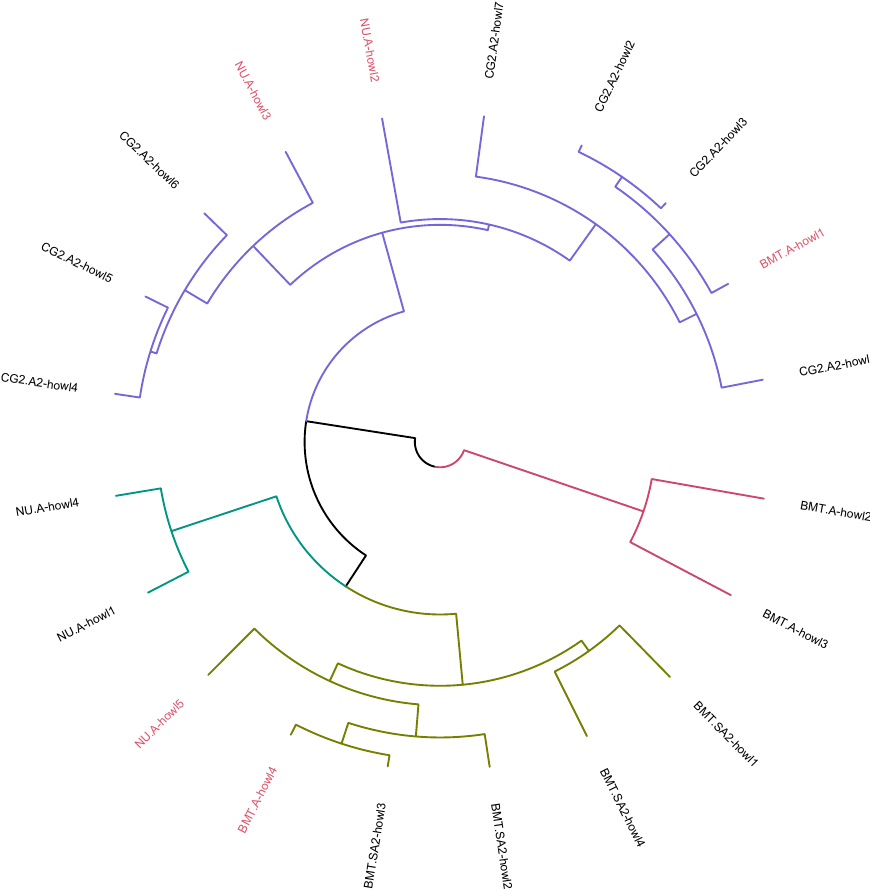
Figure 7. Hierarchical Clustering of 20 howls from four Indian wolves. None of the 20 howls was used in training the data. 15 howls were identified correctly with the accuracy of 75%, and all the four individuals were identified correctly as different clusters. The correctly identified howls are marked in black, and the five wrongly identified howls are marked in red.